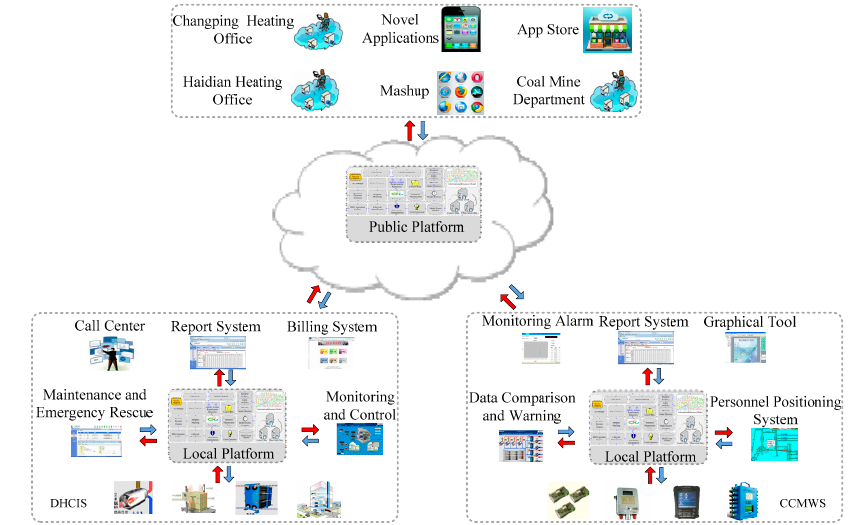
Figure 8. Framework demonstration.